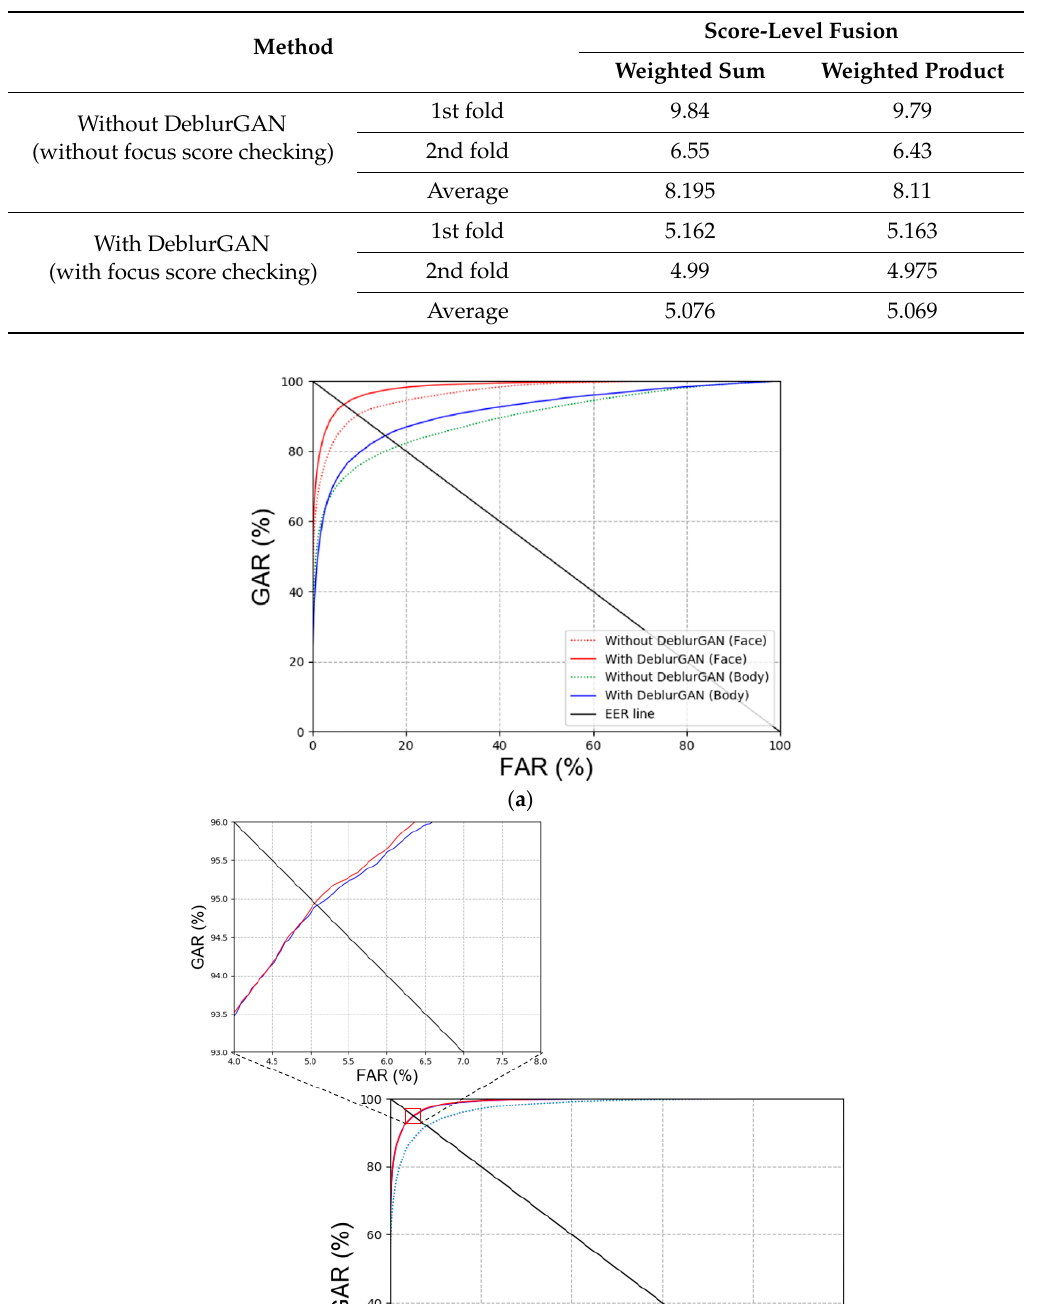
Table 11. Comparison of EER for score-level fusion on ChokePoint dataset without or with DeblurGAN (unit: %).